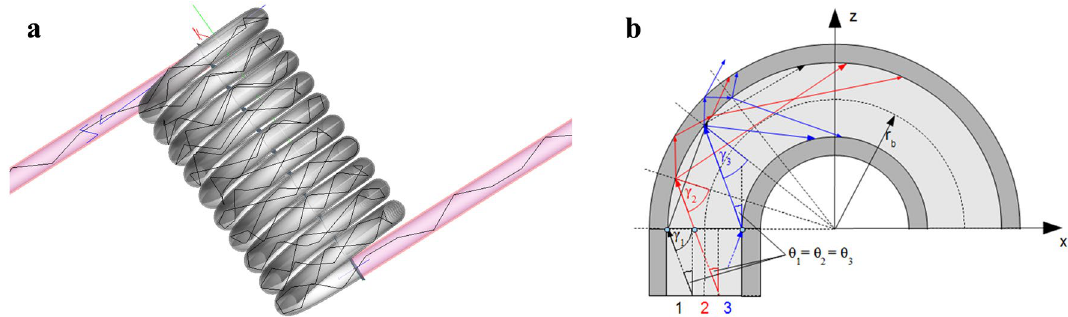
Figure 4. ( a ) Ray-tracing model with 10 bends (not to scale). ( b ) Ray paths within a bent fibre for several entry points with the same polar angle